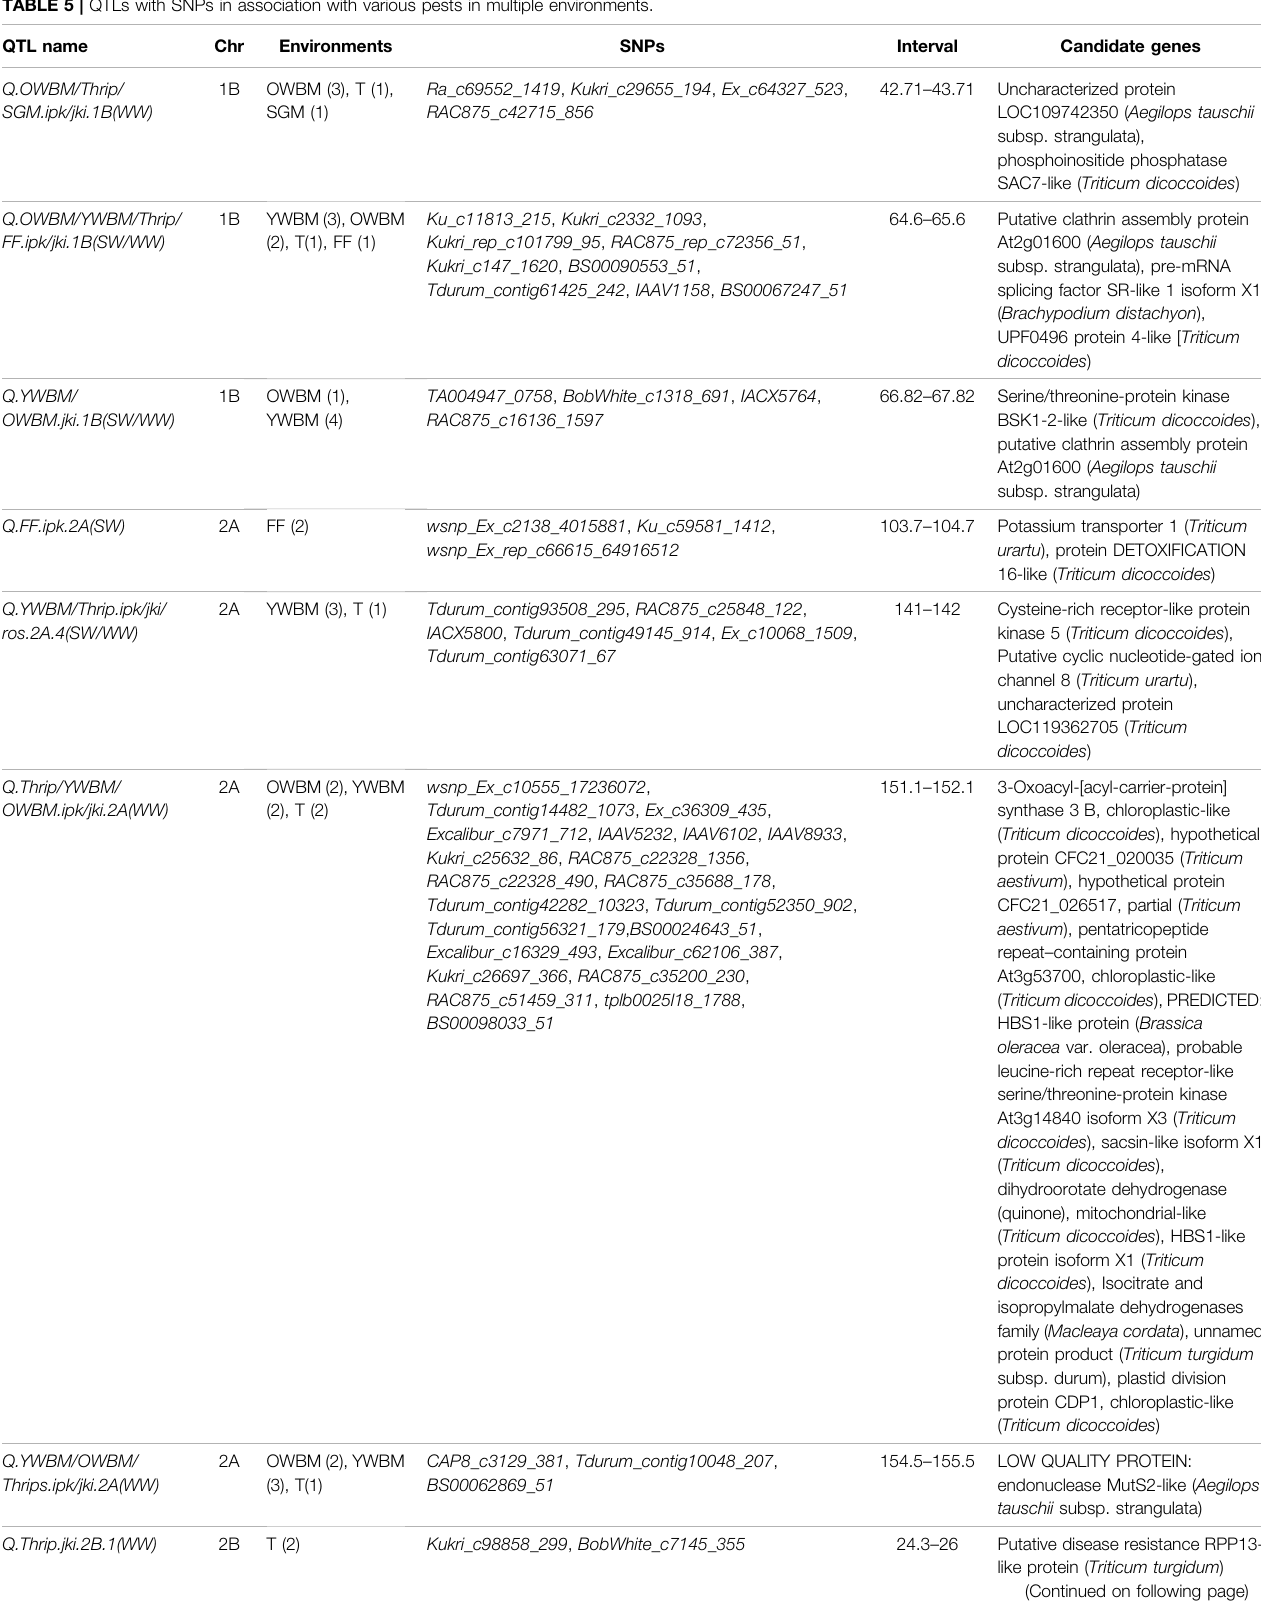
TABLE 5 | QTLs with SNPs in association with various pests in multiple